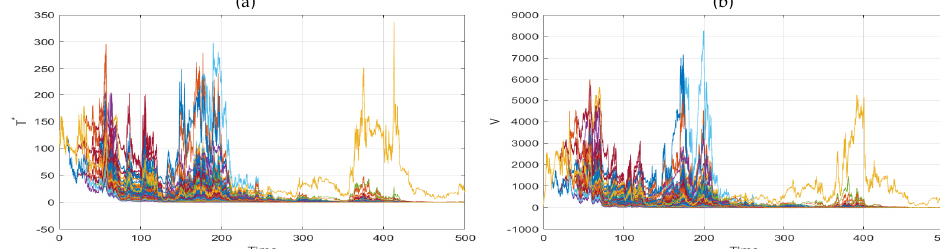
Figure 6. The dynamics of model (2) when the conditions of Theorems 2 and 3 do not hold, where R ∗ ≈ 2.1248 > 1, R s ≈ 2.3873 > 1 and 2 ˆ δ < ˇ σ 2 : ( a ) trajectories of T ∗ ( t ) ; ( b ) trajectories of V ( t ) . The 0 2 0 500 trajectories of the same initial value indicate that the evolution of the virus shows irregularities under the perturbation of